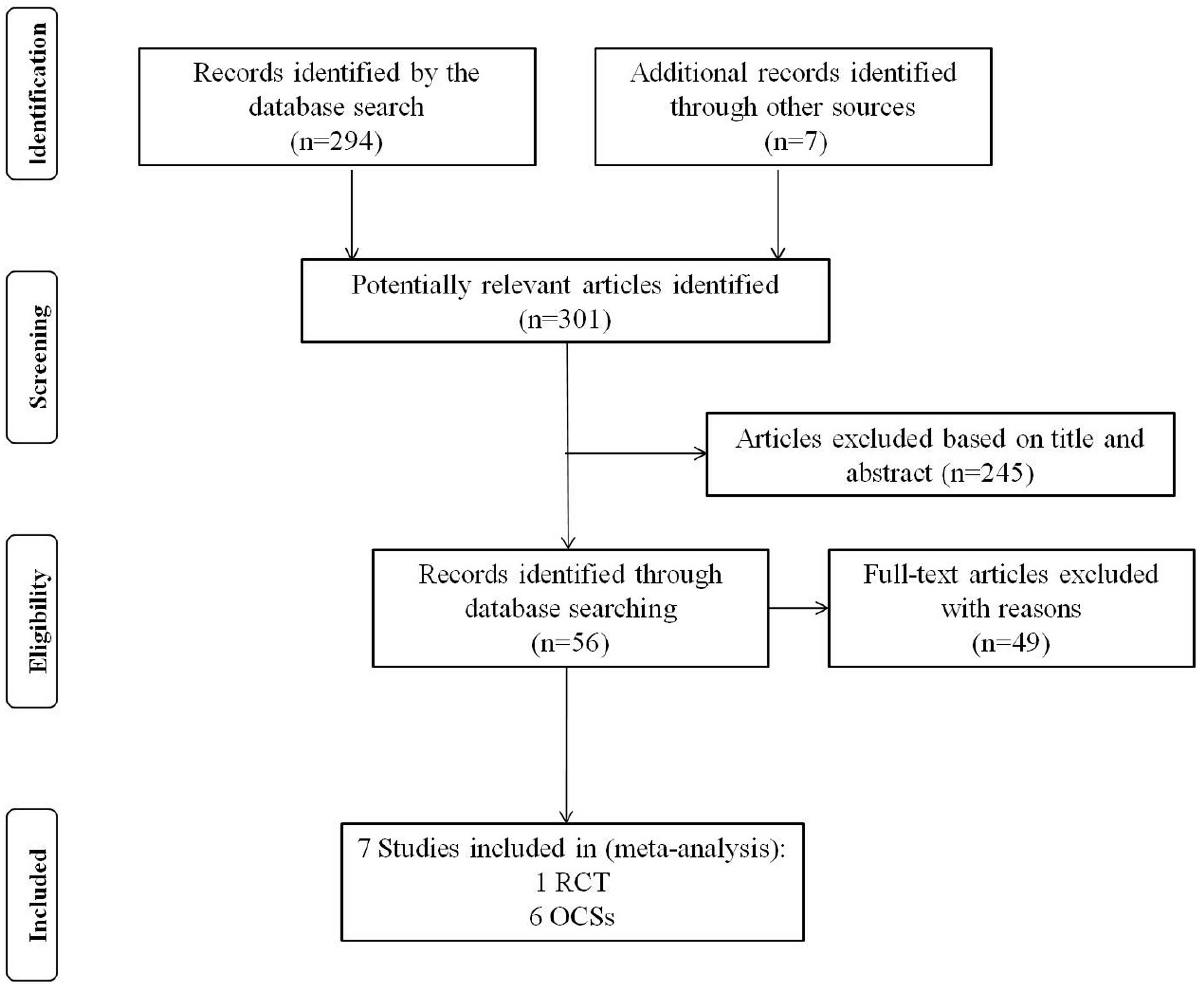
Figure 1 - Study selection process for the studies included in the Meta-Analysis (based on the PRIMA